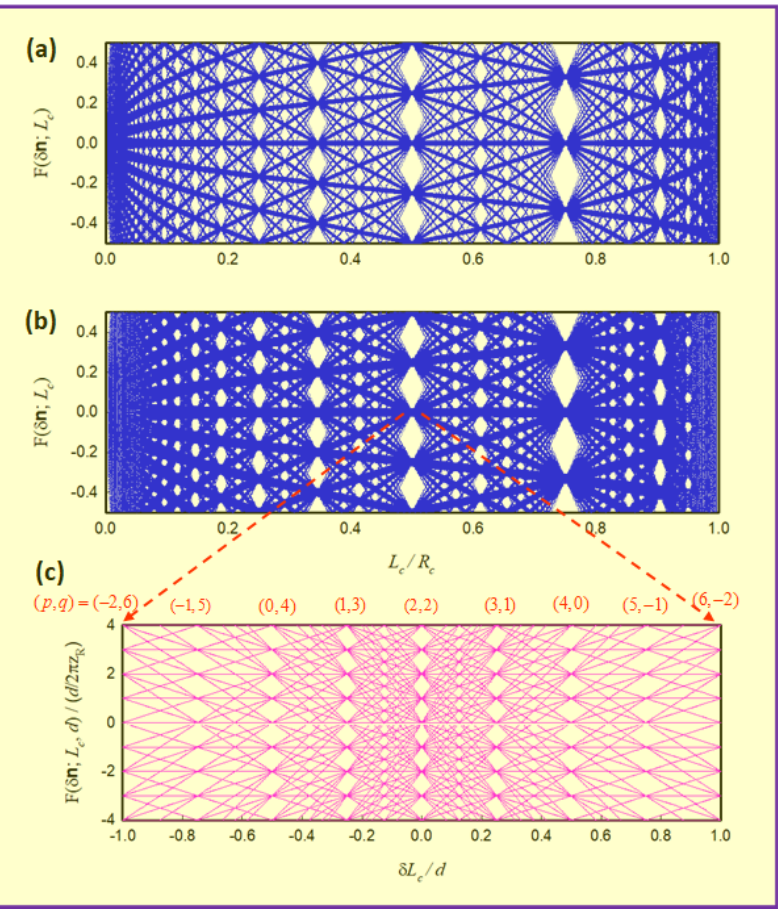
Figure 9. Eigenfrequency spectrum F ( δ n ; L c , d ) as a function of L c / R c for | δ n for ( a ) d / R c = 3.3 × 10 − 3 , ( b ) d / R c = 6.6 × 10 − 3 , ( c ) new fine degeneracies near P / Q =